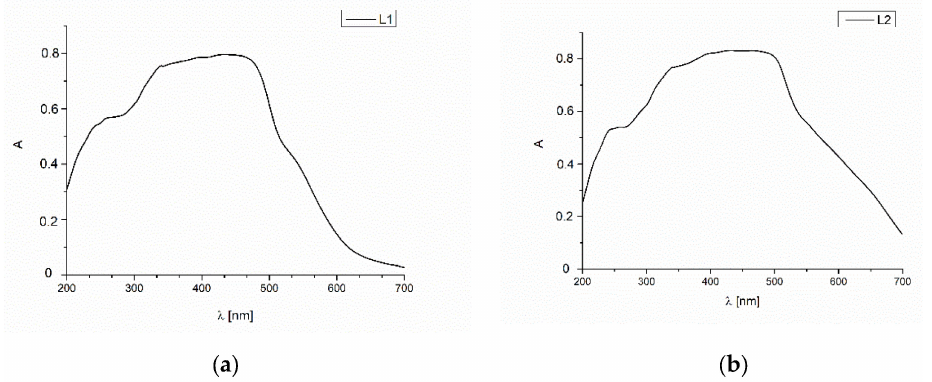
Figure 7. Solid state absorption spectra od ( a ) L1 and ( b ) L2